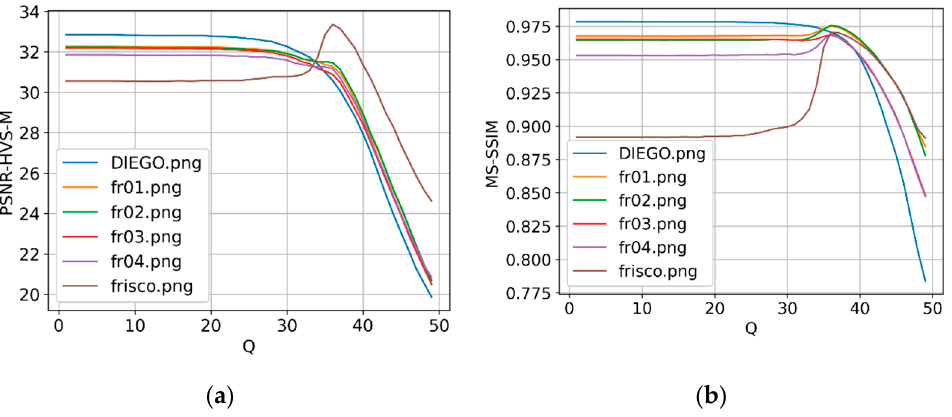
Figure 7. Dependences PSNR − HVS − M tc ( Q ) ( a ) and MS − SSIM tc ( Q ) ( b ) for noise variance equal to 100.